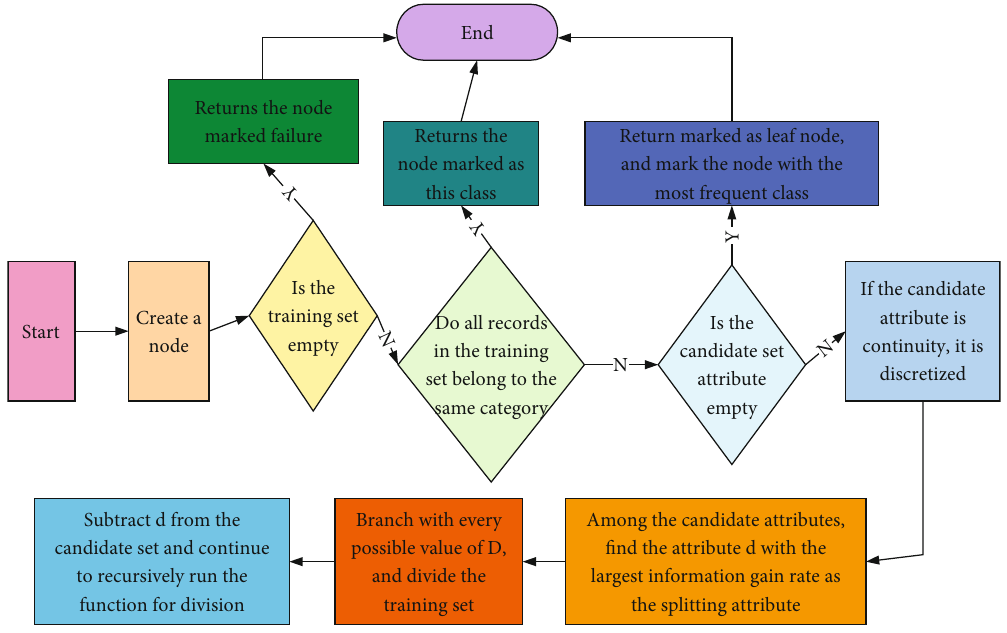
Figure 6: C5.0 algorithm fl owchart. Table 2: Composition of in fl uencing factors of hospital catering service